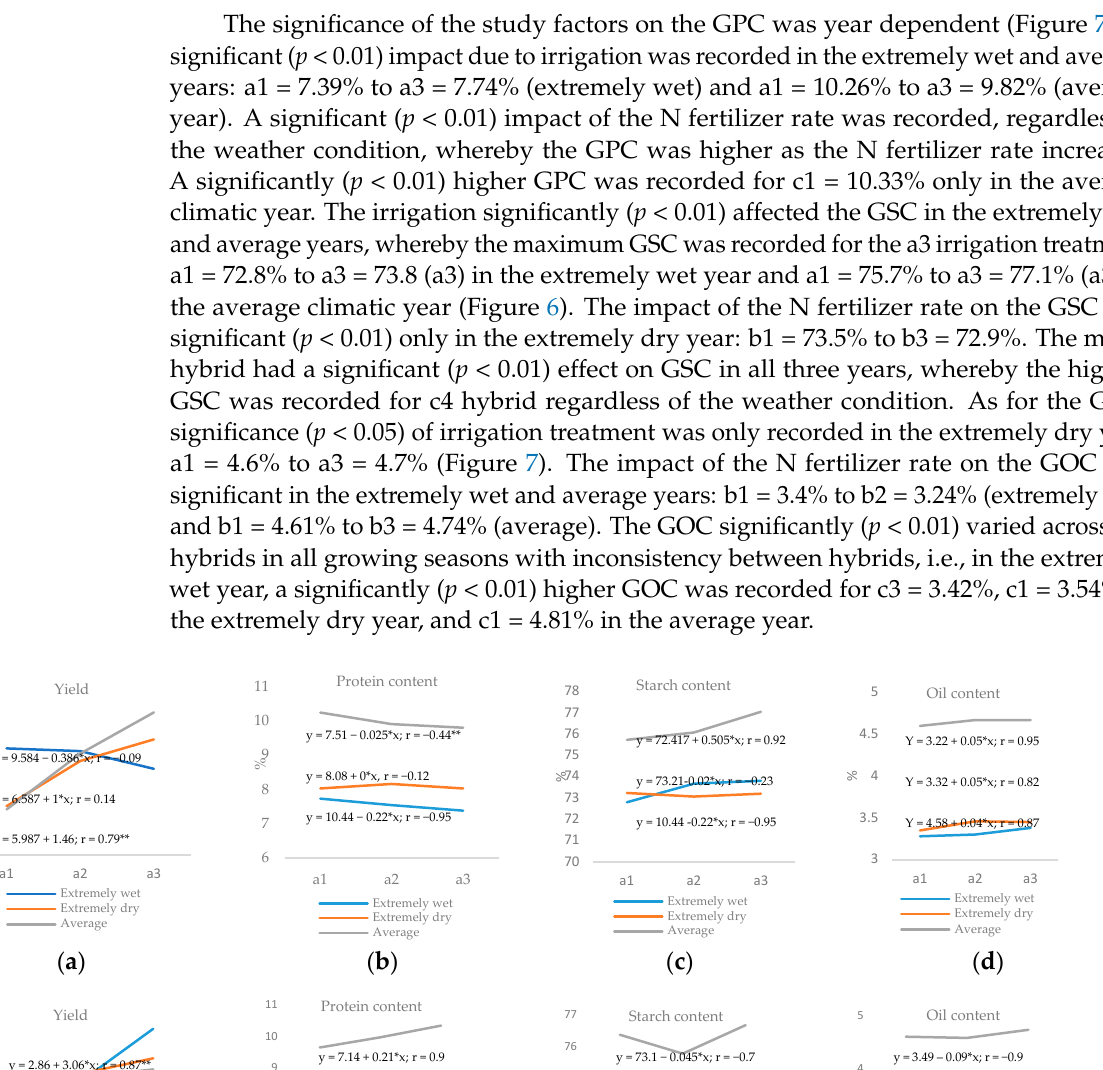
Figure 6. Averages and significances (ANOVA) of the GY, protein, starch, and oil content across the irrigation (a1 = rainfed, a2 = 60–100% field capacity (FC), and a3 = 80–100% FC), N fertilizer rate (b1 = 0 kg N ha − 1 , b2 = 100 kg N ha − 1 , b3 = 200 kg N ha − 1 ), and maize hybrid (c1 = OSSK596, c2 = OSSK617, c3 = OSSK602, and c4 = OSSK552) variables.